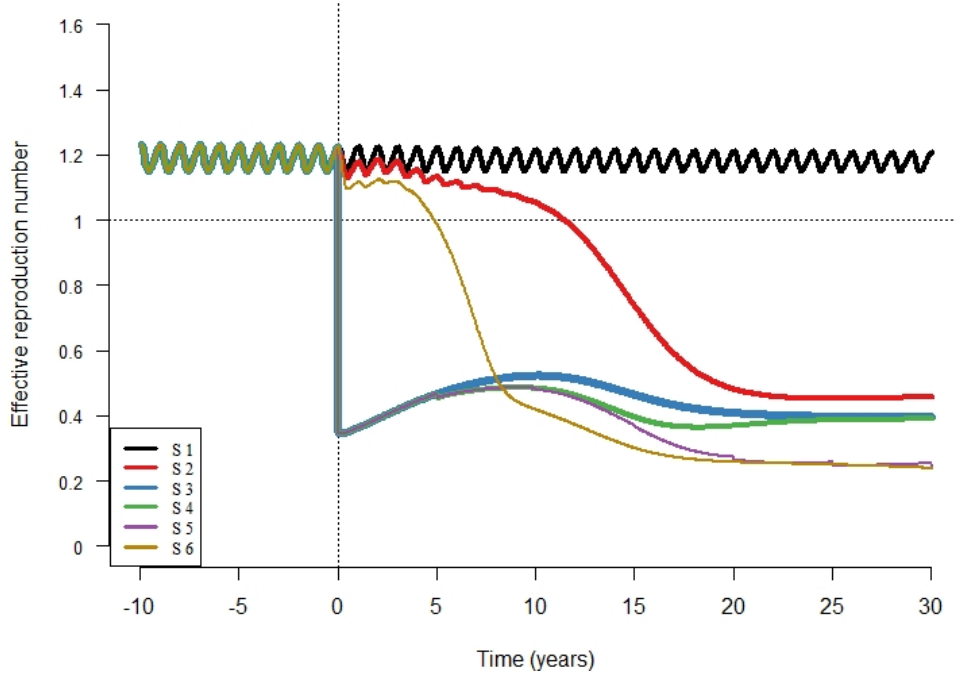
Figure 5. R effective (R E ) over time for all scenarios (S1 = scenario 1, S2 = scenario 2, S3 = scenario 3, S4 = scenario 4, S5 = scenario 5, S6 = scenario 6) with vaccine coverage for both routine immunization and campaigns (if relevant to the scenario) set at 80%. The X axis shows time from 10 years prior to RCV introduction to 30 years after RCV introduction. The vertical dotted line represents the year of RCV introduction and the horizontal dotted line represents the value for the effective reproductive number above which outbreaks are likely to occur.